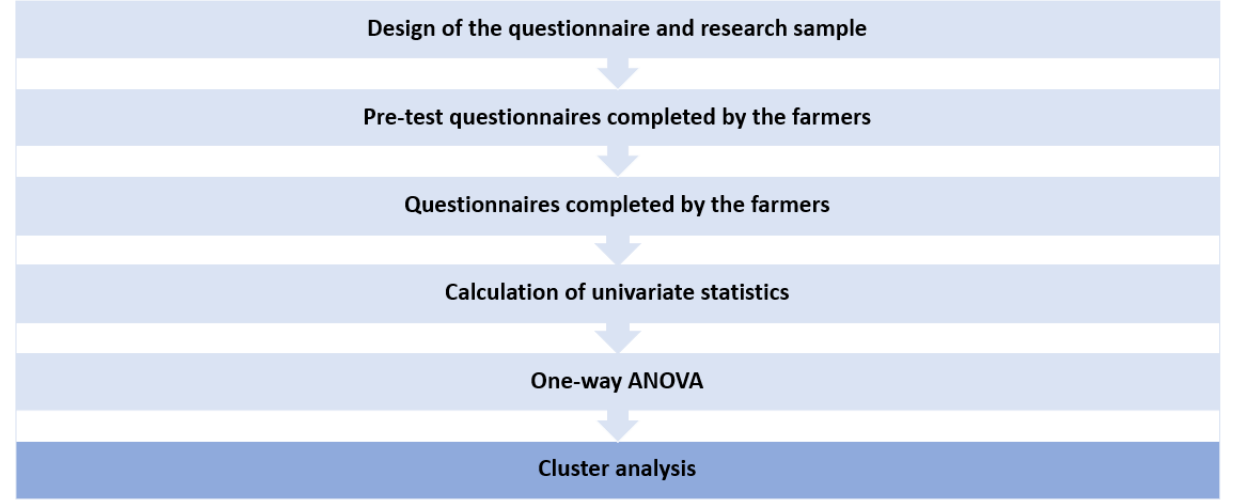
Figure 2. Methodology followed.